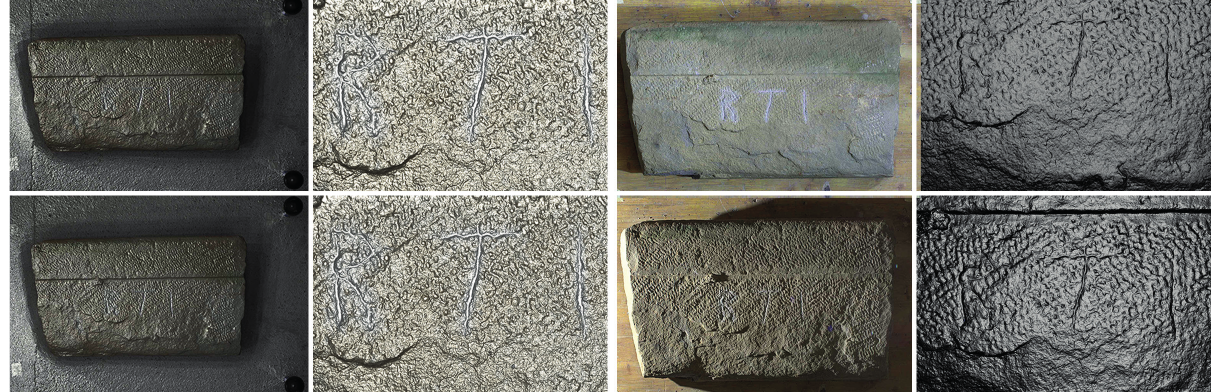
Figure 8. Laboratory tests for the best use of the RTI technique: on the left, RTI images from object illuminated with only grazing light and grazing plus diffuse light; on the right, photogrammetric 3D model made with shots taken with only diffuse light and grazing plus diffuse